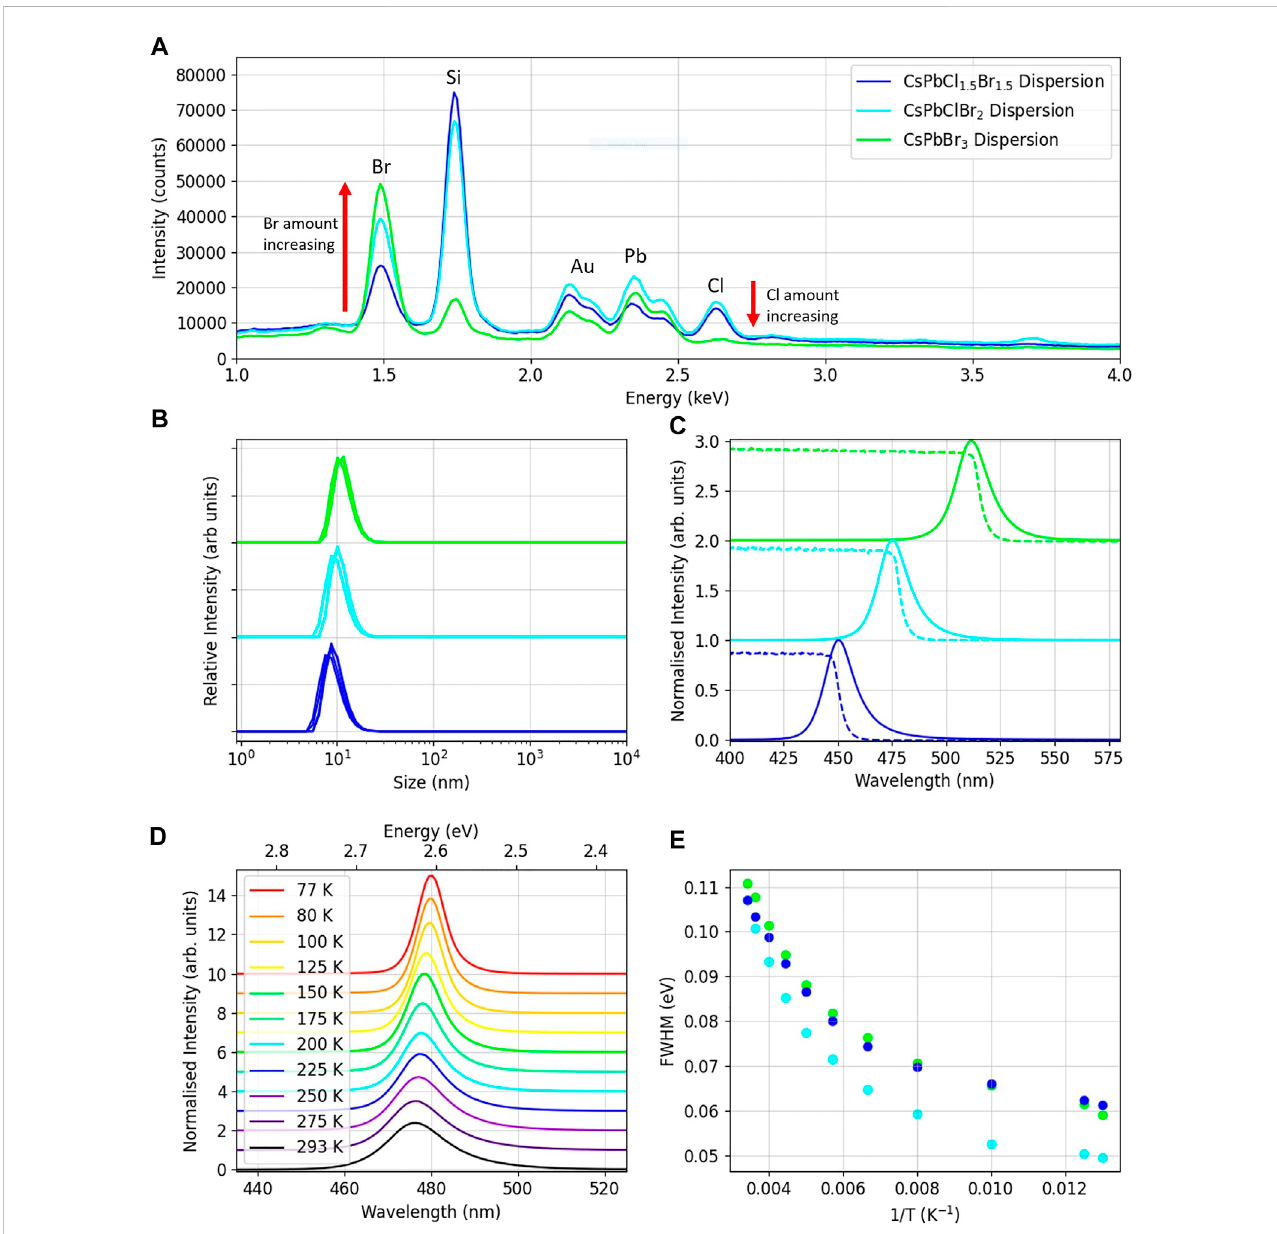
FIGURE 2 (B) Size distributions of the dispersions measured using DLS. (C) Absorption and PL (A) EDX spectra of samples of the three CsPbCl x Br 1 − x materials. spectra of the dispersions. (D) PL emissions for the CsPbClBr 2 dispersion over the temperature range 293-77K. (E) The FWHM against inverse temperature for the dispersions over the temperature range